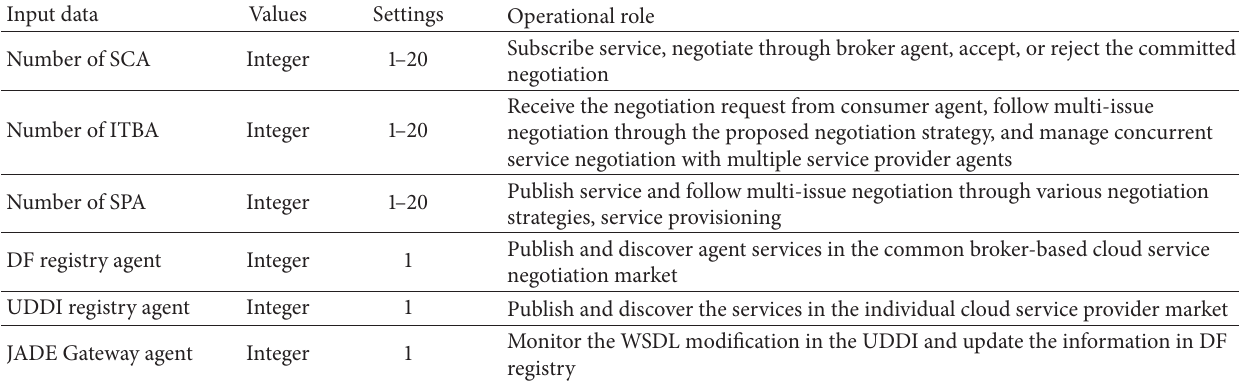
Table 3: Experimental data source: cloud service negotiation framework.